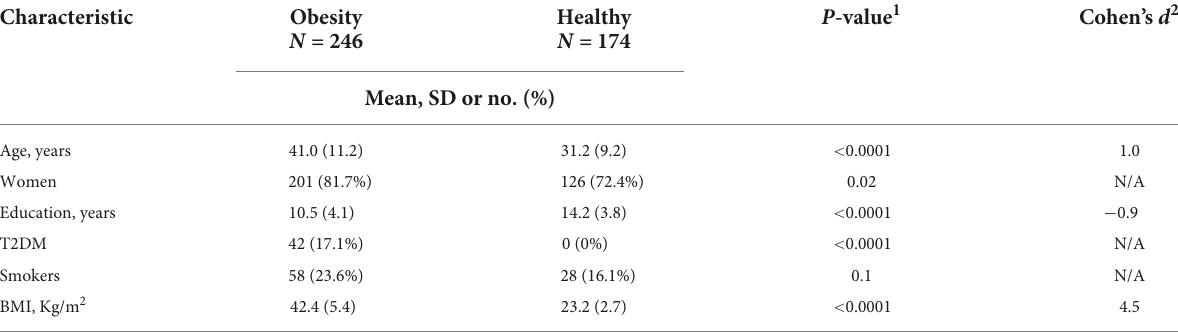
TABLE 1 Demographic characteristics of the study groups.